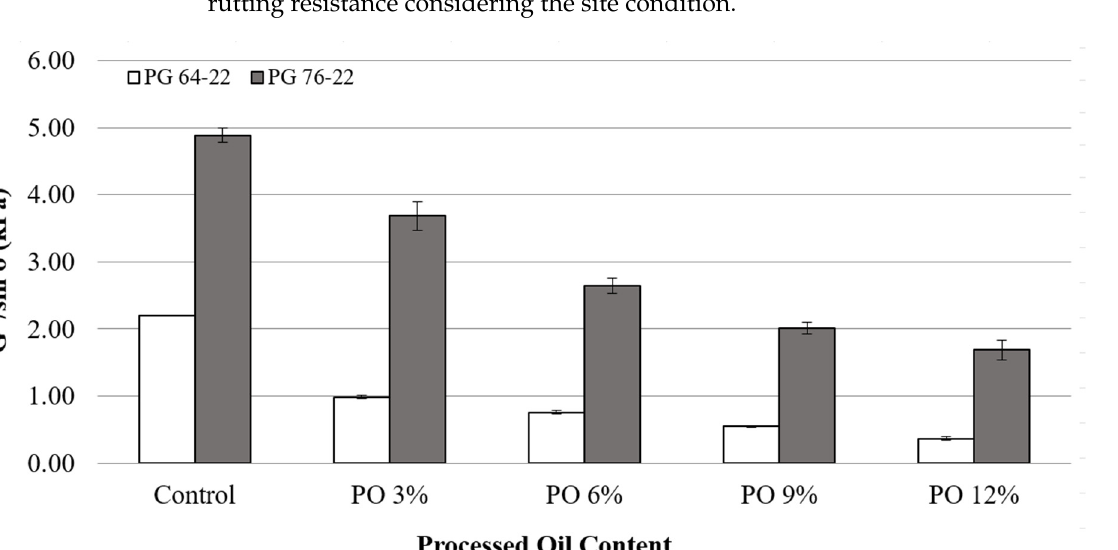
‐ S: significant N: non ‐ significant. Figure 6 illustrates the values of G*/sin δ for both binder types of PG 64 ‐ 22 and PG 76 ‐ 22 in a short ‐ term aging state (RTFO). A similar decrement trend was observed for this condition as before aging. The samples were tested at 64 °C and compared to unaged binders. The application of processed oil transformed the molecular structure of the as ‐ phalt binders and decreased the viscosity. The G*/sin δ values decreased by 32, 45, 60, and 71% as processed oil content increased with 3% interval from 3% to 12%. On the other hand, with the same values of processed oil for PG 76 ‐ 22, the G*/sin δ values decreased by 24, 45, 54, and 65%, respectively. In both binders, under short ‐ term aging occasions, the results showed a decrement of viscosity because of rejuvenating the asphalt binder via processed oil. Table 6 shows the statistical analysis of changes due to the addition of processed oil in both binder types. In general, significant differences in G*/sin δ results of both base binders were observed depending on oil content, except for results between 3% and 6% and 9% and 12%, indicating the effect of processed oil on rutting performance is practical even in short ‐ term aged binders.